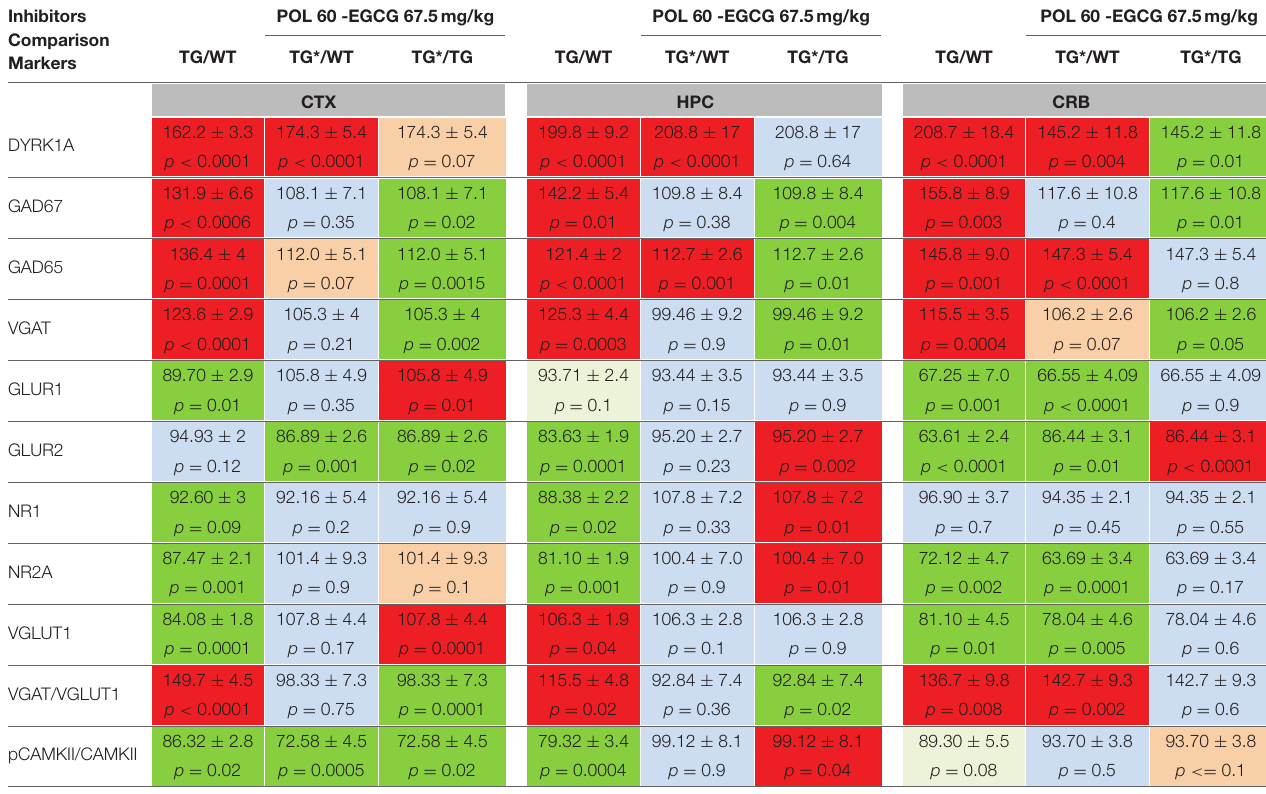
TABLE 1 | Protein levels of markers of inhibition and excitation pathways for WT and mBACtgDyrk1a (TG) in cortex, hippocampus, and cerebellum following treatment with EGCG-containing POL60 extract. Inhibitors